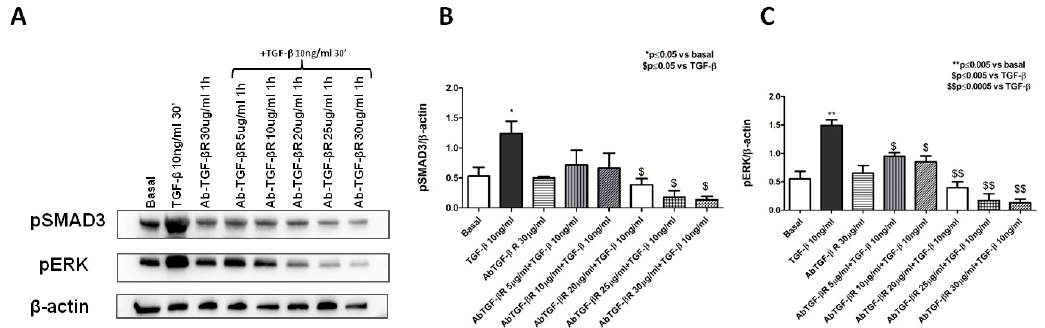
Figure A2. TGF- β R inhibition assay. ( A – C ) Pericytes were pre-treated with mouse monoclonal anti- TGF- β R at 5-10-20-25-30 μ g/mL for 1 h before the TGF- β (10 ng/mL) exposition for 30 min. Pretreatment of pericytes with anti-TGF- β R antibody at 20 μ g/mL is sufficient to significantly reduce TGF- β -induced phosphorylation of SMAD3 and ERK.